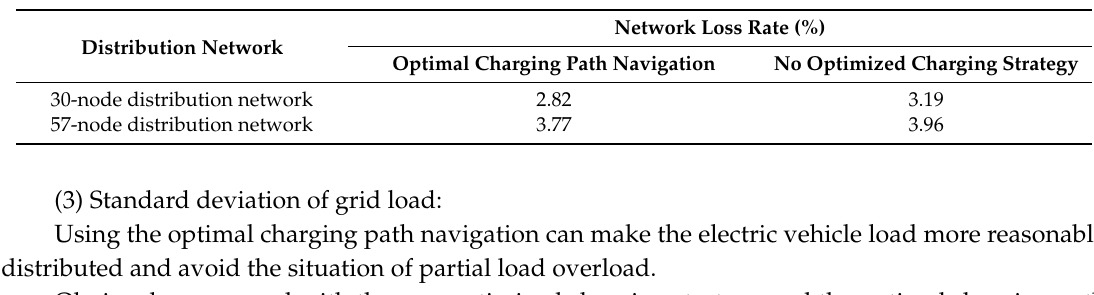
Table 4. Network loss rate.